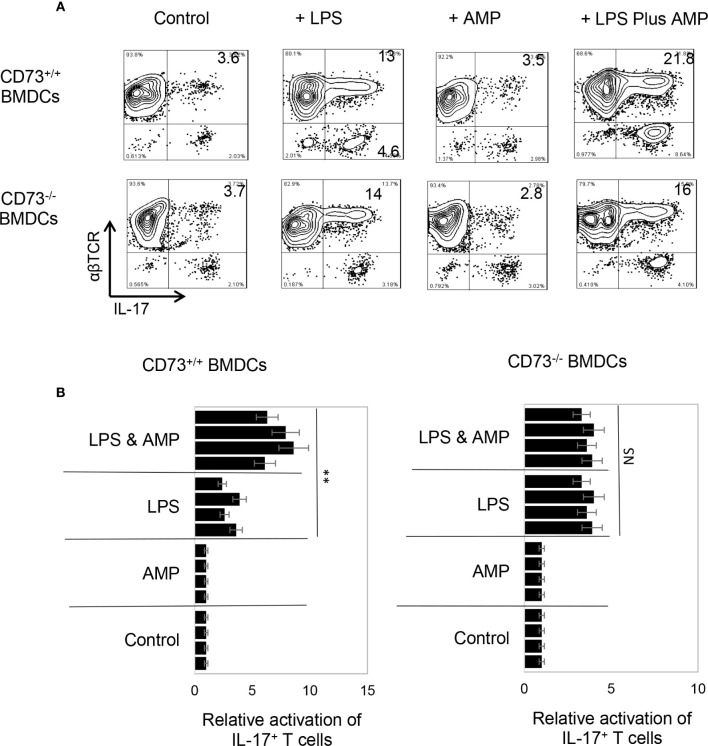
Bone marrow dendritic cells acquire response to adenosine monophosphate after lipopolysaccharide treatment (A). Synergistic effect between lipopolysaccharide (LPS) and adenosine monophosphate (AMP) in enhancing bone marrow dendritic cells’ (BMDCs’) Th17 promoting activity. BMDCs from B6 (CD73+/+) (upper panels) or CD73−/− (lower panels) mouse were examined for antigen presenting function, after exposure to LPS (100 ng/ml) or LPS plus AMP (1 μM). Responder T cells obtained from immunized B6 mice. The numbers of IL-17+ T cells among responder T cells were examined after staining with anti-IL-17 and anti-αβTCR mABs, after a 5-day in vitro stimulation under Th17 polarizing conditions. The data are from one single experiment and are representative of those obtained in three independent experiments (B). Summarized data of four separate experiments showing that AMP enhanced BMDCs’ Th17 stimulating effect only after LPS treatment (left panels) and that the CD73−/− BMDCs remained unresponsive to AMP even LPS treatment (right panels). Values of relative activation of Th17+ T cells were calculated by number of IL-17+ T cells in testing group divided by number of IL-17+ T cells in the control group (in the absence of LPS and AMP) and are expressed as mean ± SEM (n = 4). **p < 0.05. ns, not significant.